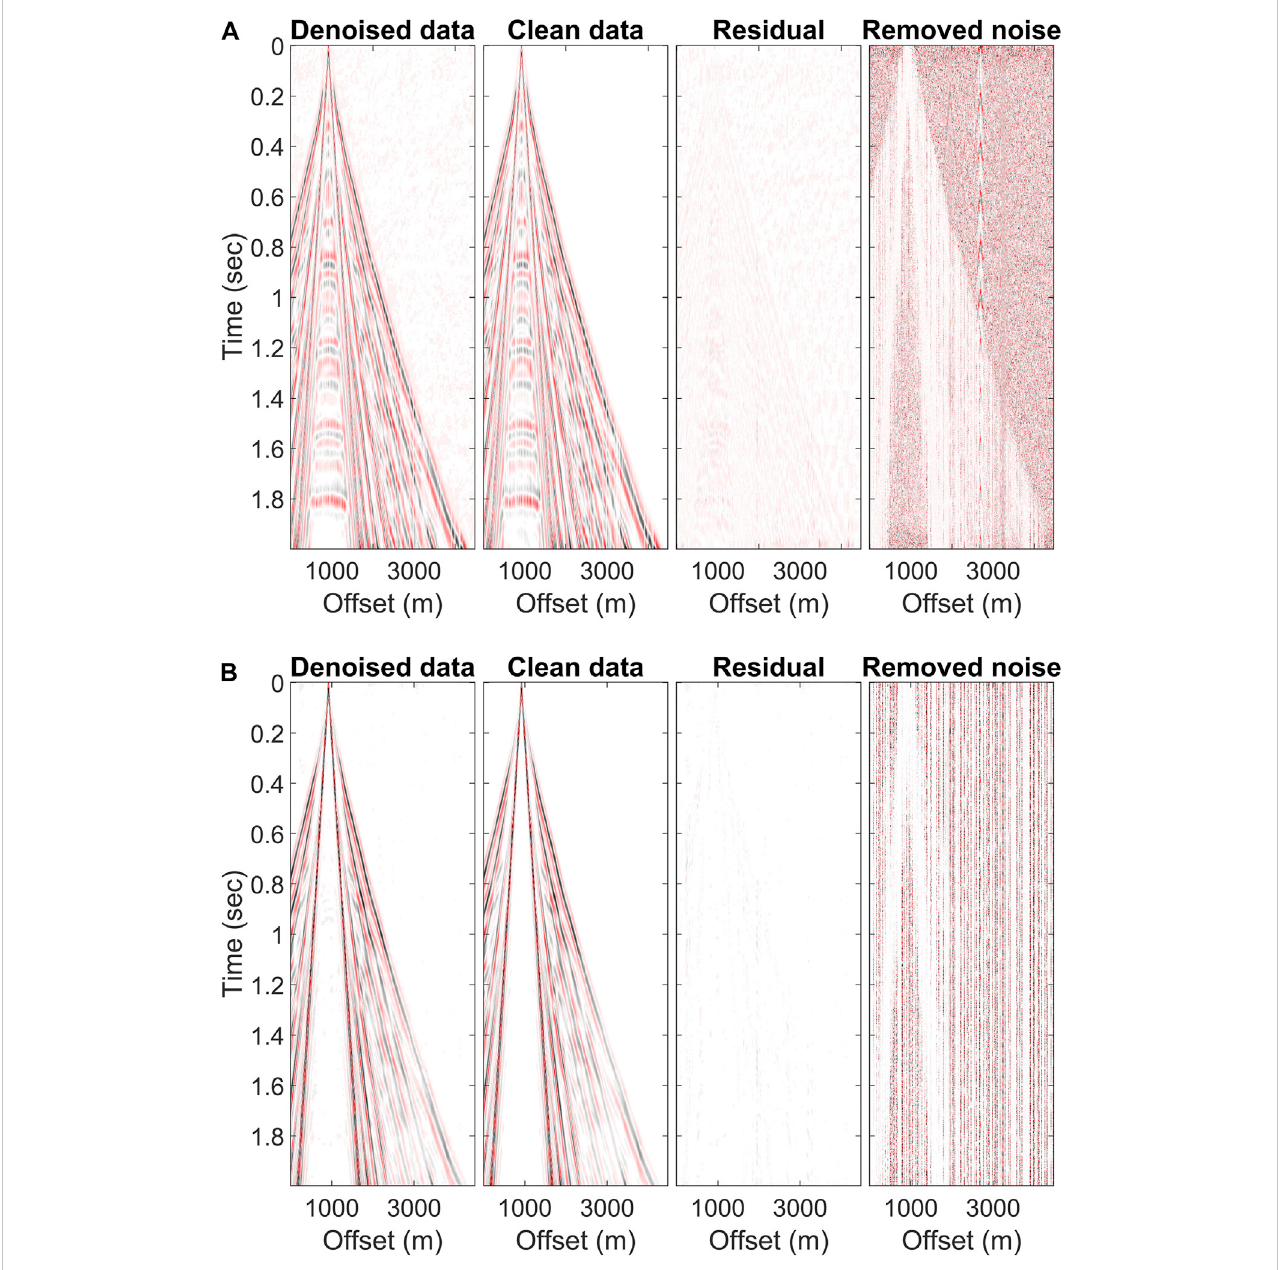
FIGURE 5 Desired clean data and the predicted denoised results in network training with amplitude recovered using the (A) AGC method and (B) 2D AGC method. The residual and the removed noise are, respectively, the clean data and the noisy data subtracted from the denoised results.